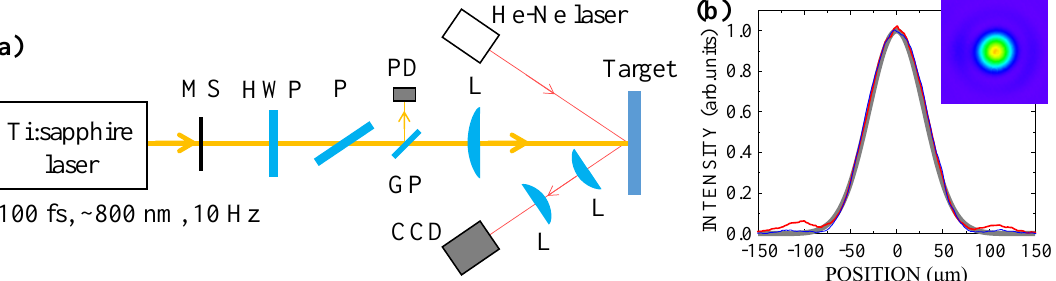
Figure 2. ( a ) Schematic diagram of the optical configuration for the ablation experiment. MS, mechanical shutter; HWP, half-wave plate; P, polarizer; GP, glass plate; PD, photodetector; L, lens. ( b ) Intensity profile of the focal spot of a fs pulse. The red and blue curves represent the horizontal and vertical profiles, respectively, with a Gaussian profile shown in gray for comparison. The inset shows a CCD image of the focal spot.